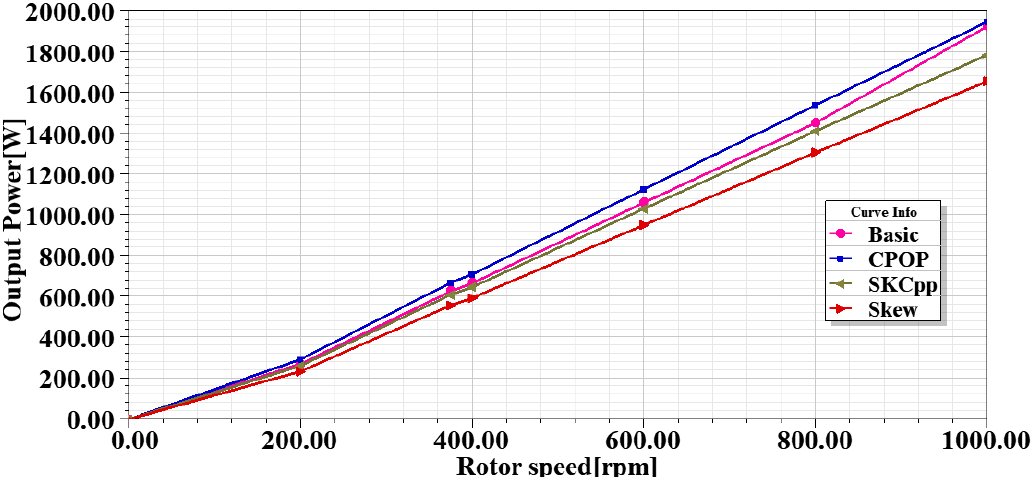
Figure 33. Output-power against mechanical speed (rpm) for each rotor design @ 375 r/min.